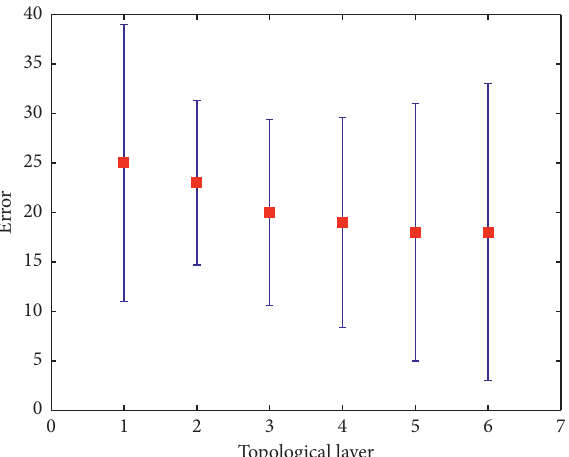
Figure 8: The error distribution of the number of layers in the propagation model